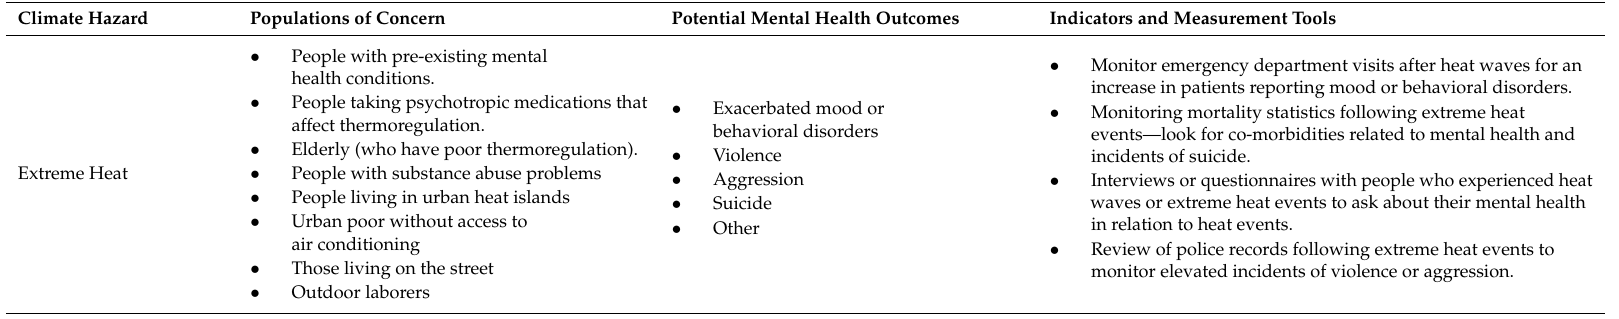
Table 1. Monitoring and Measuring the Climate Change Impacts to Mental